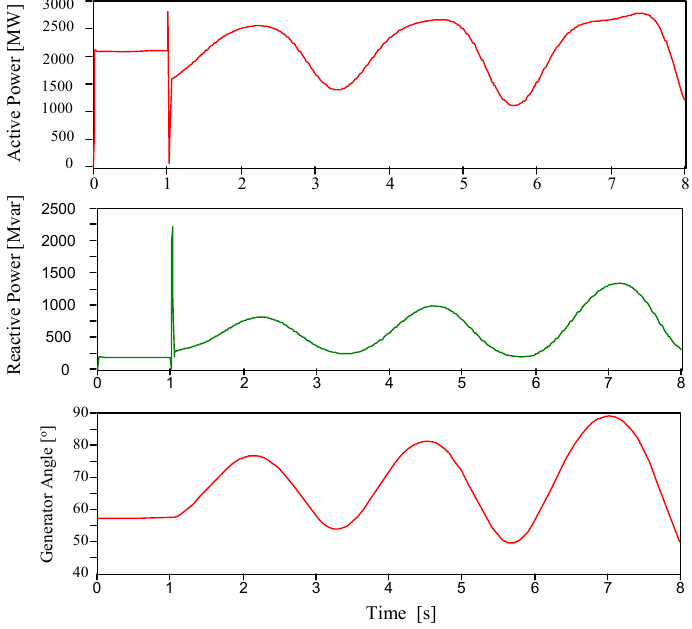
Figure 10. Time variation of generator angle δ and reactive power Q after the occurrence of the fault. 4.3. Three Phase Fault: Clearing Time After 10 Cycles When the fault clearing time is 10 cycles, the elliptic trajectory of the complex power is as shown in Figure 11. The time difference is only nine cycles between Case 4.2 and Case 4.3. Upon the inception of a three-phase fault, the generator angle grows beyond 90°. Figure 12 shows the variation of the generator angle and the reactive power after the fault. During the first 7.5 s, the two trajectories are similar. At 7.5 s, the out-of-step condition of the generator begins to develop. From the results of this simulation, the variation of reactive power can be used instead of the generator angle to detect the out-of-step condition. In other words, it shows that the out-of-step state can be detected by monitoring the reactive power trajectory, and this can be used in the estimation of the stability of the power system. Figure 11. The trajectory of complex power in a complex plane (the fault clearing time is 10 cycles).